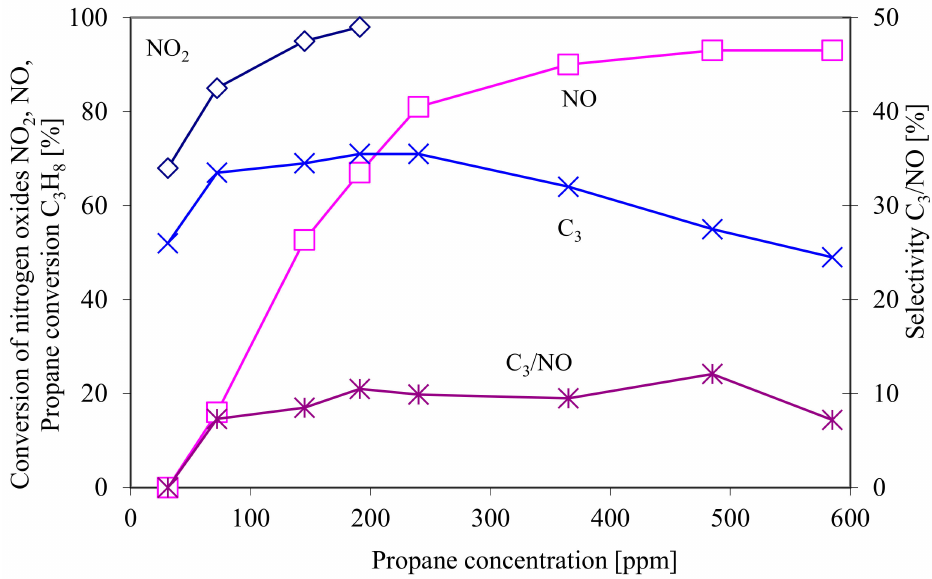
Figure 10. The conversion of nitrogen oxides and of propane, as well as the selectivity of propane as a function of propane concentration upstream of the catalytic converter at the constant temperature of the catalytic process T = 500 ◦